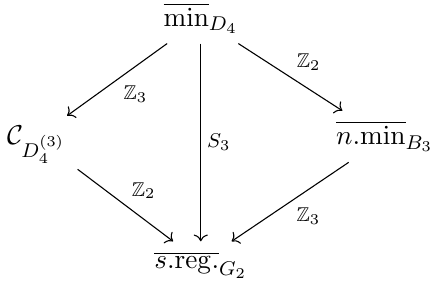
Figure 1 . Commutative Diagram of the orbifolding of min D